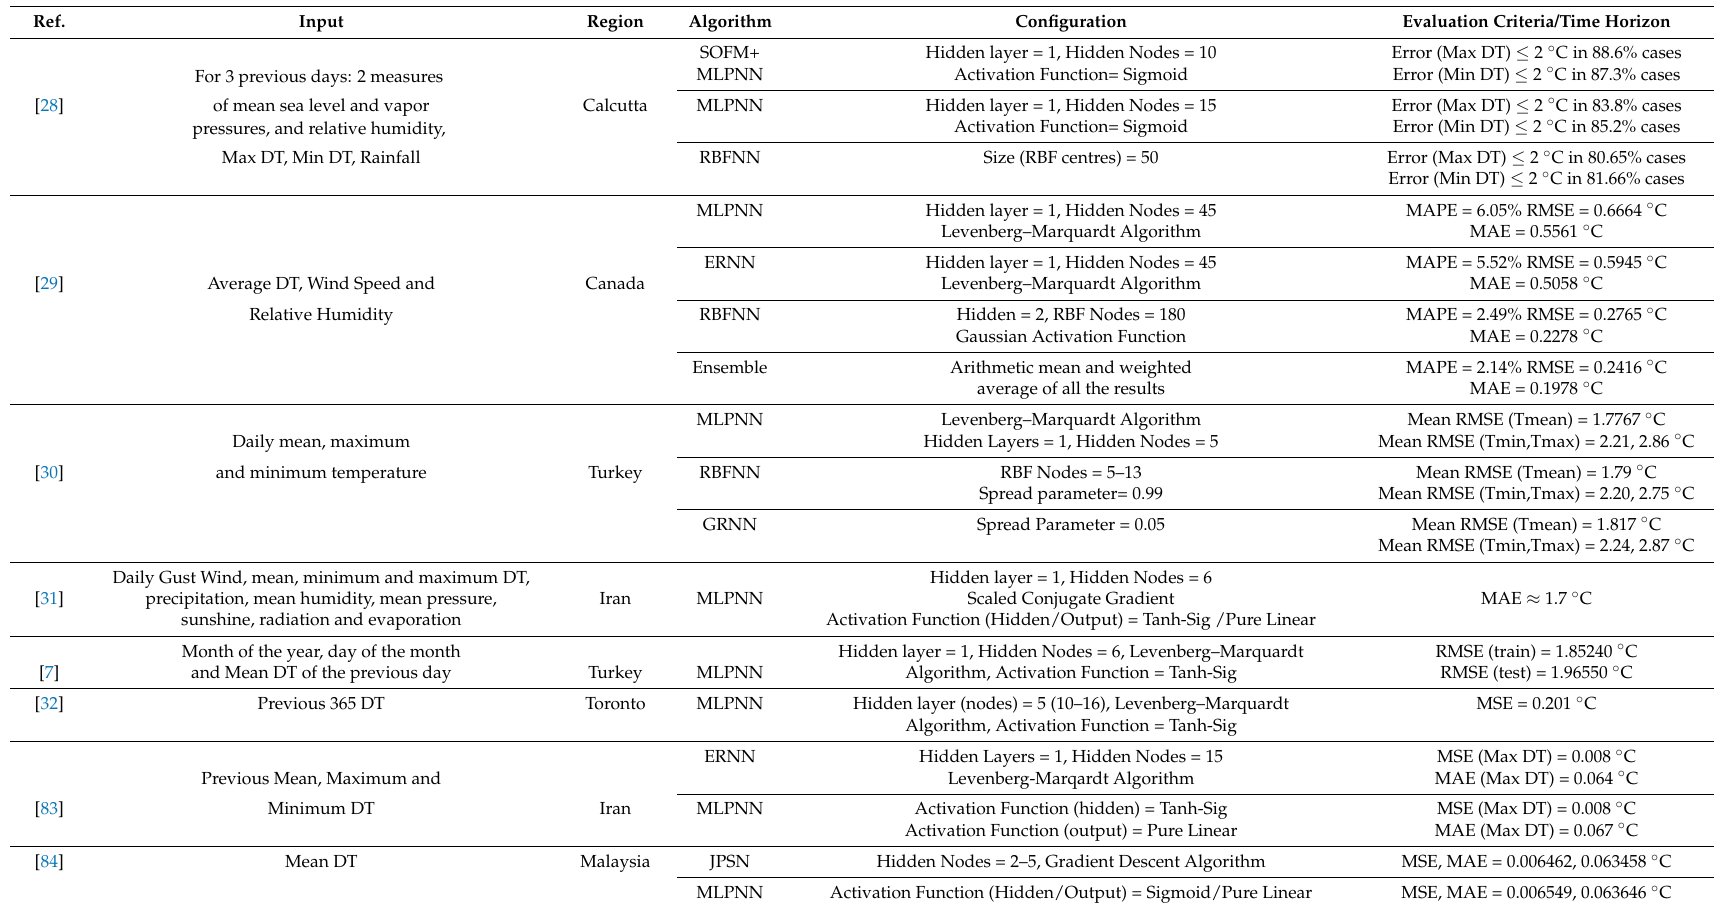
Table 3. Representative papers related to Daily Temperature